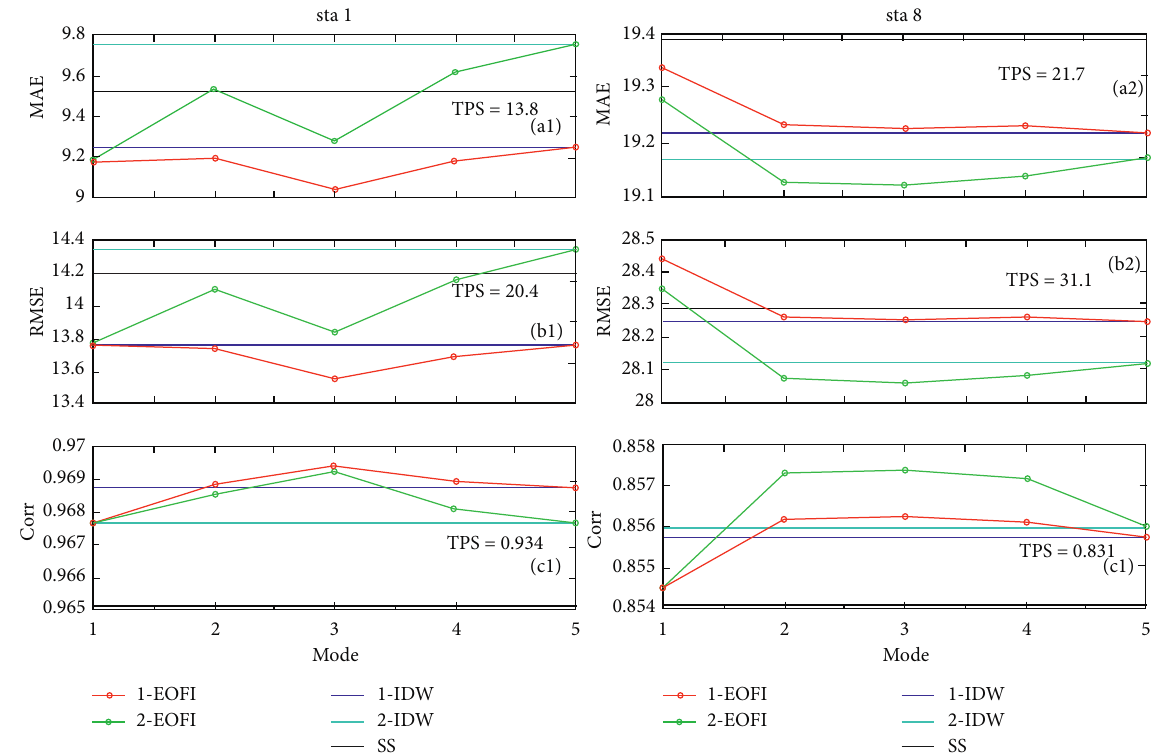
Figure 6: MAE, RMSE, and Corr of 4 interpolation methods in sta 1 and sta 8. The horizontal axis is the number of the first k modes selected in EOFI. The results of the other three interpolation methods are all straight lines and irrelevant to the data of sta 9 are not used for sta 8. The 4 sites and 5 sites EOFI reconstruction results are shown in Table 3.